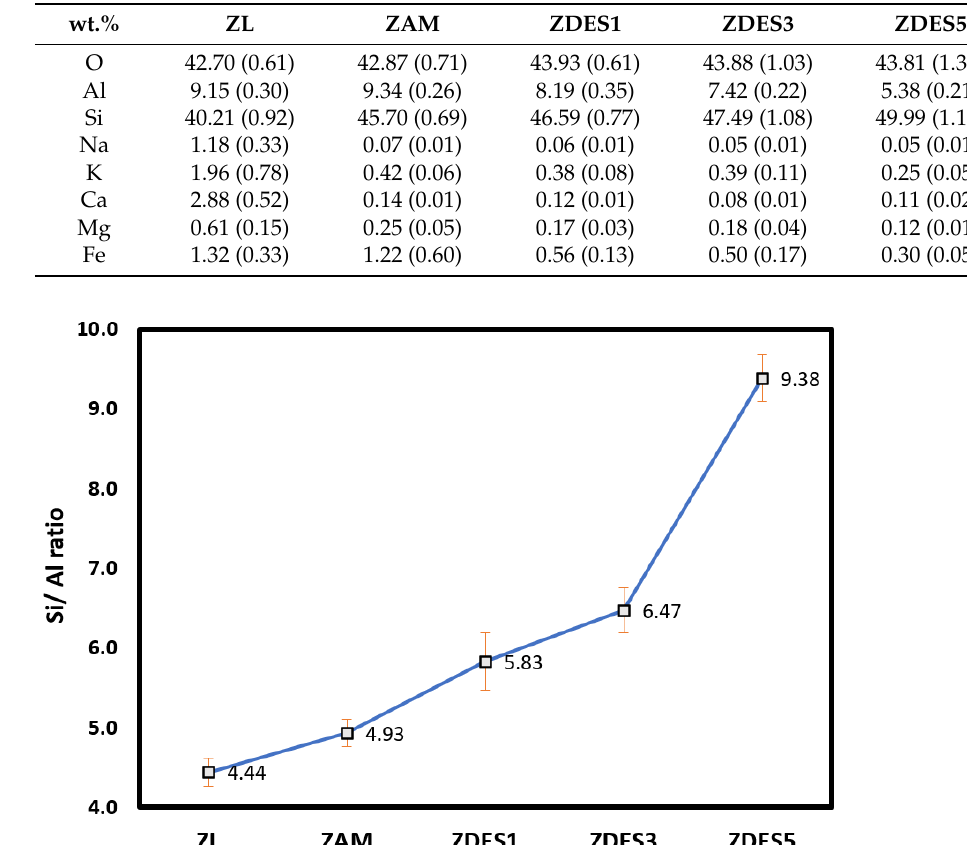
Figure 5. Variation in Si/Al ratio of the raw material (ZL); ammonia-exchanged sample (ZAM); and dealuminated samples (ZDES1, ZDES3, and ZDES5). dealuminated samples (ZDES1, ZDES3, and